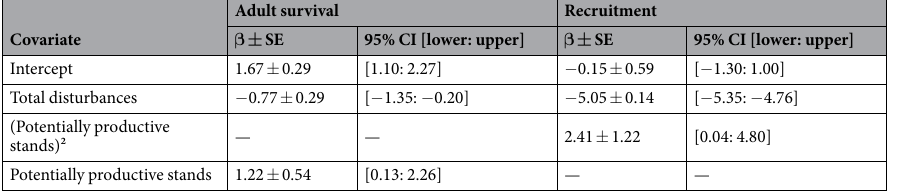
Table 1. Parameter estimates (coefficients, standard errors, and 95% confidence intervals) of mixed-effects models describing the effects of total proportion of disturbances and proportion of potentially productive stands (squared, in the case of recruitment) on the annual survival of adult female caribou, and on recruitment (i.e., calf/female ratio observed during aerial surveys) to six boreal caribou populations distributed over 380,000 km 2 of eastern Canadian boreal forest ( n = 24 surveys among the six populations). Overall, observed values ranged between 0.22 and 0.78 for total proportion of disturbances and between 0.04 and 0.85 for proportion of potentially productive stands.